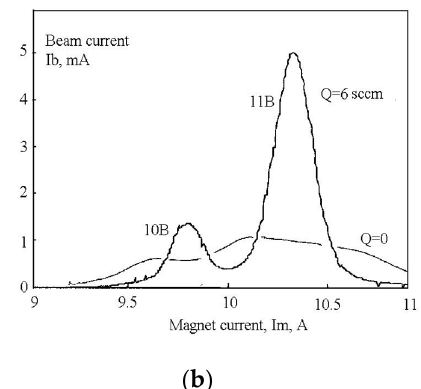
Figure 7. Photograph of 11 B + beam after analyzer without electronegative gases and with electro- negative gases. Ion beam instability was damped by admixture of optimized electronegative gas den- sity as shown on Figure 8. The beam current fluctuation level decreased with increased injection of electronegative gases. Figure 8. Ion beam current after analyzer showing damping of beam instability by injection of different quantities of elec- tronegative gas. Q is in sccm (standard cubic centimeters per minute).